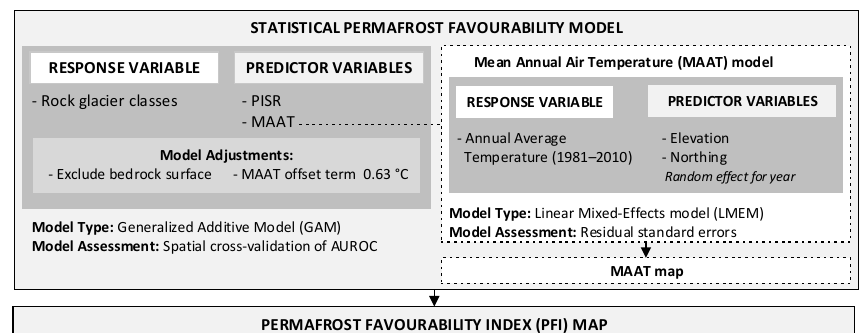
Figure 2. General methodological framework of permafrost favourability and MAAT